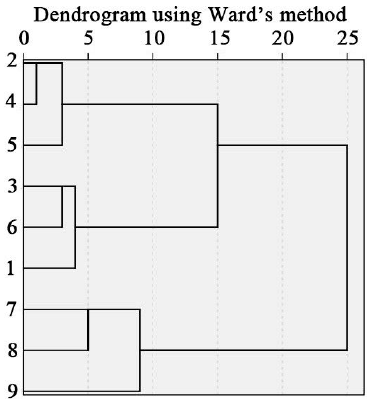
Figure 8: Correlation dendrogram for In-situ tensile test